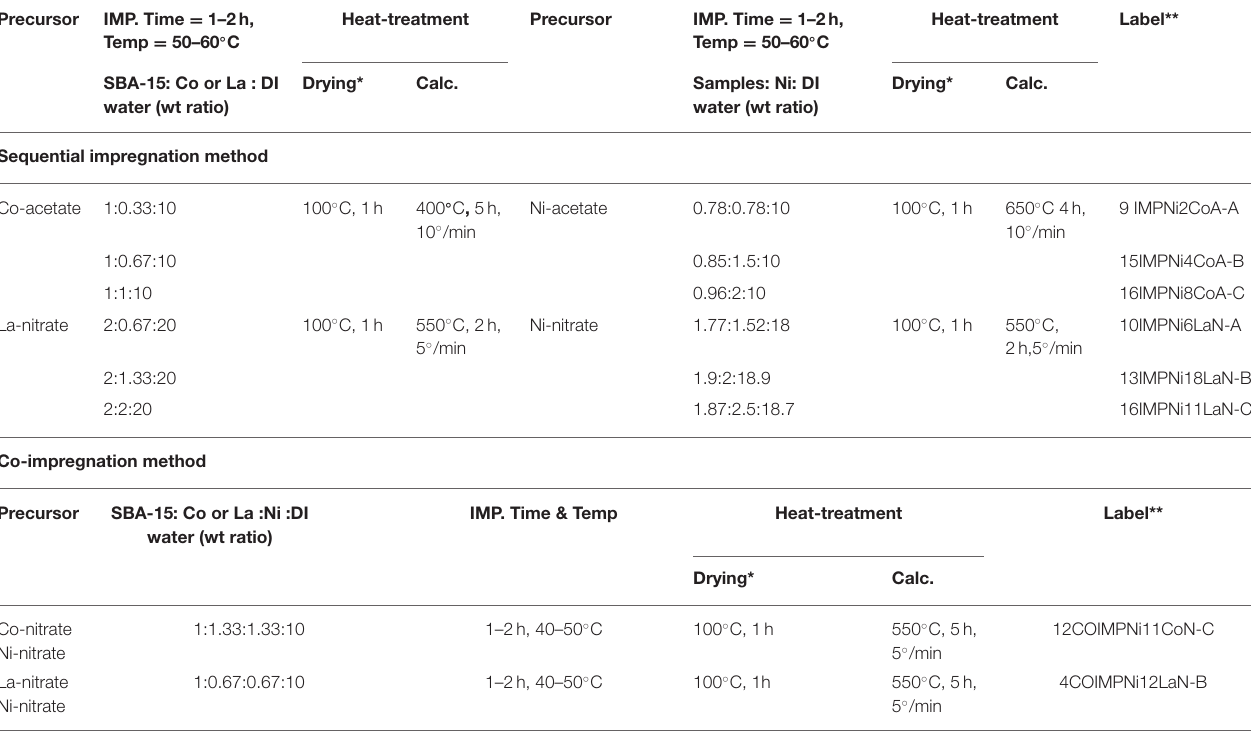
TABLE 2 | Preparation conditions and labels for the bimetallic Ni-Metal/SBA-15 samples. Precursor IMP. Time = 1–2h, Temp = 50–60 ◦